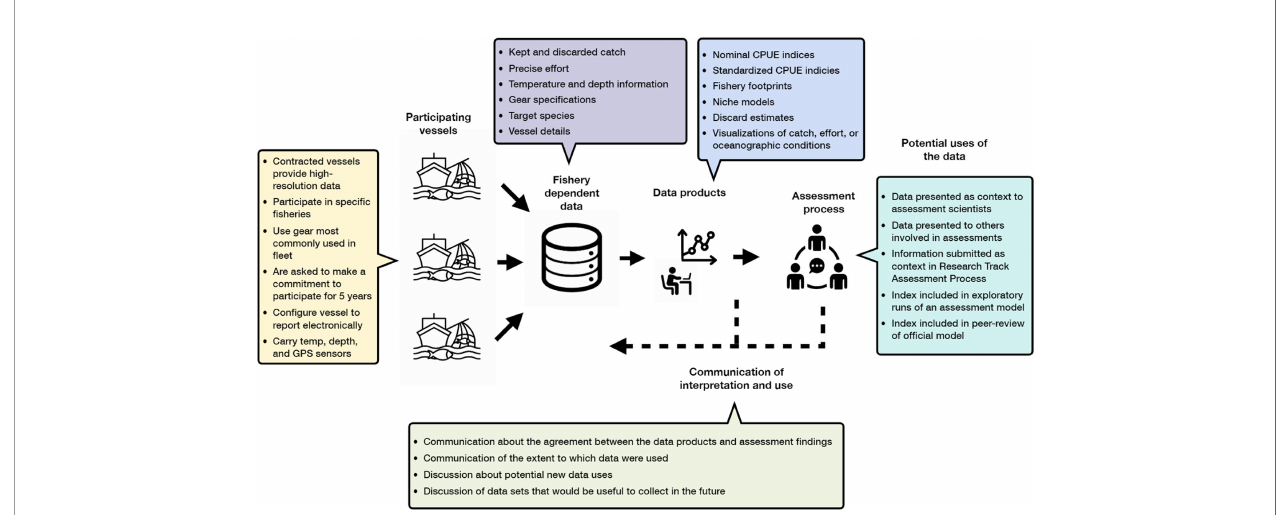
FIGURE 1 | A conceptual diagram of the data fl ow and purpose of the Study Fleet program. Starting with the reporting vessels and fi shermen (yellow) information fl ows to the Science Center (purple and blue) where it is curated and developed into analytical products for science and management. These products are presented as part of the assessment process (darker green) and then communicated back to participating captains (light green). This cycle is simpli fi ed in many ways as iterative loops are likely to improve the products and